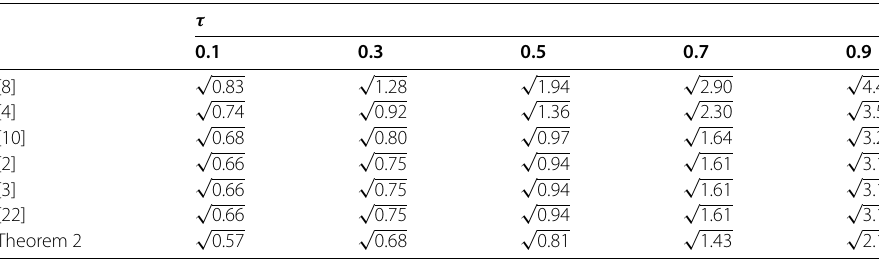
Table 4 Computed r ’s of Example 4 for different values of τ with μ =